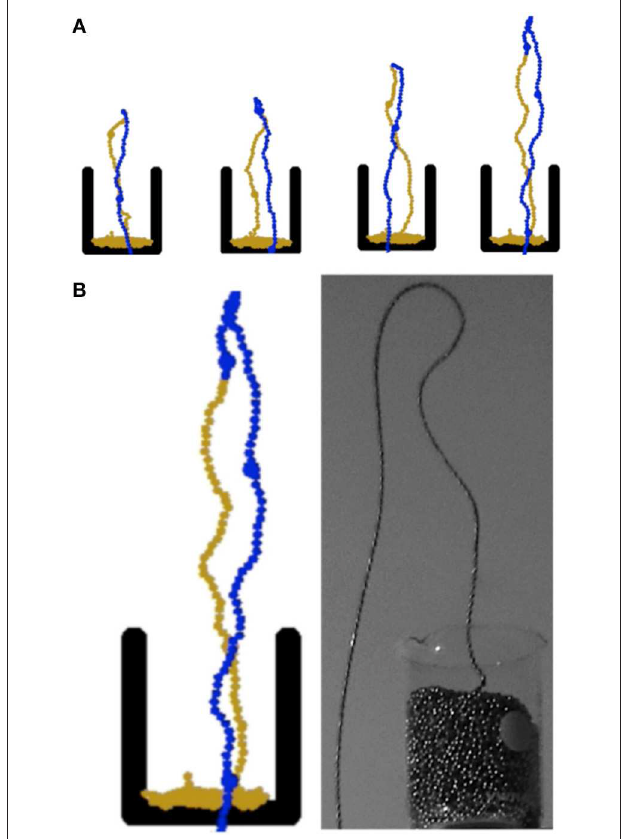
This force is applied to every bead. If 2 max is zero this would result in a long rigid chain, so we choose it in stead to the measured value 2 max = 63 degrees. When 2 max is zero, and the force is applied to every third particle, the model of Equation (26) is